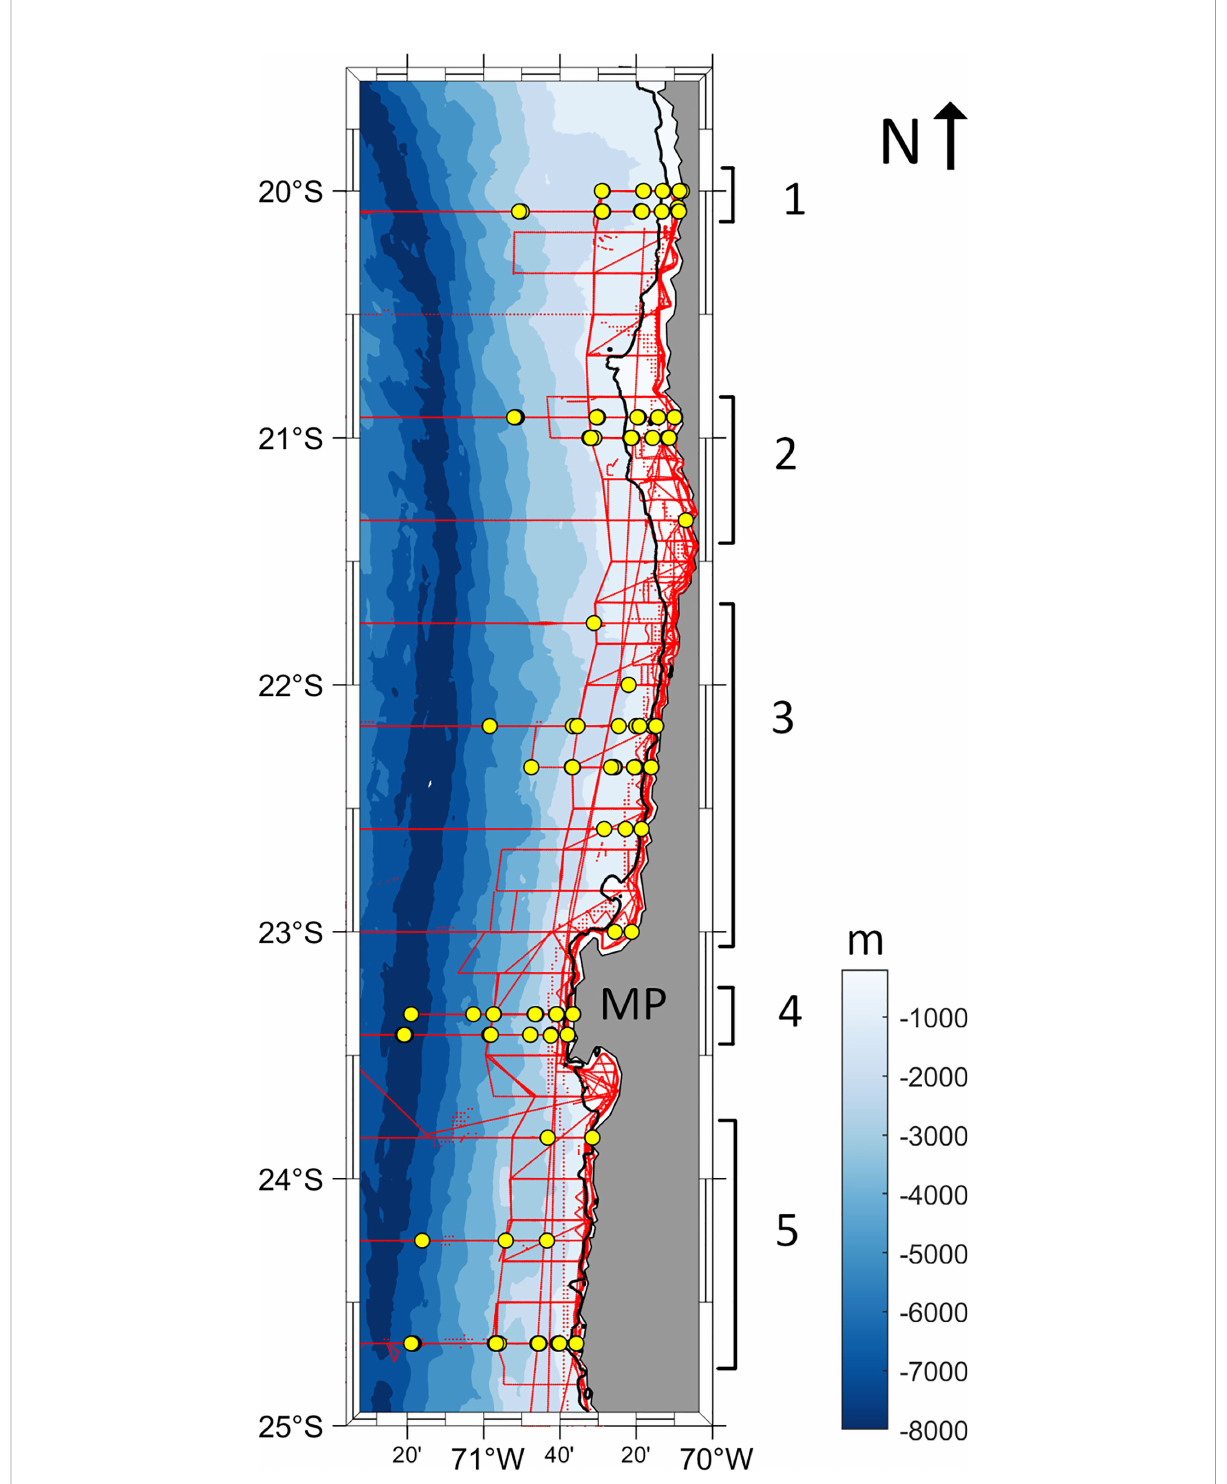
FIGURE 1 Map of the study area showing the bathymetry (color coded) and 200 m isobath as a black line. Yellow dots represent the zooplankton and CTD-O sampling stations. Red dots (seen as red lines because of the high spatial resolution of the data) represent the anchovy acoustic sampling records. Samples were grouped in 5 latitudinal groups (numbers 1-5, de fi ned in the